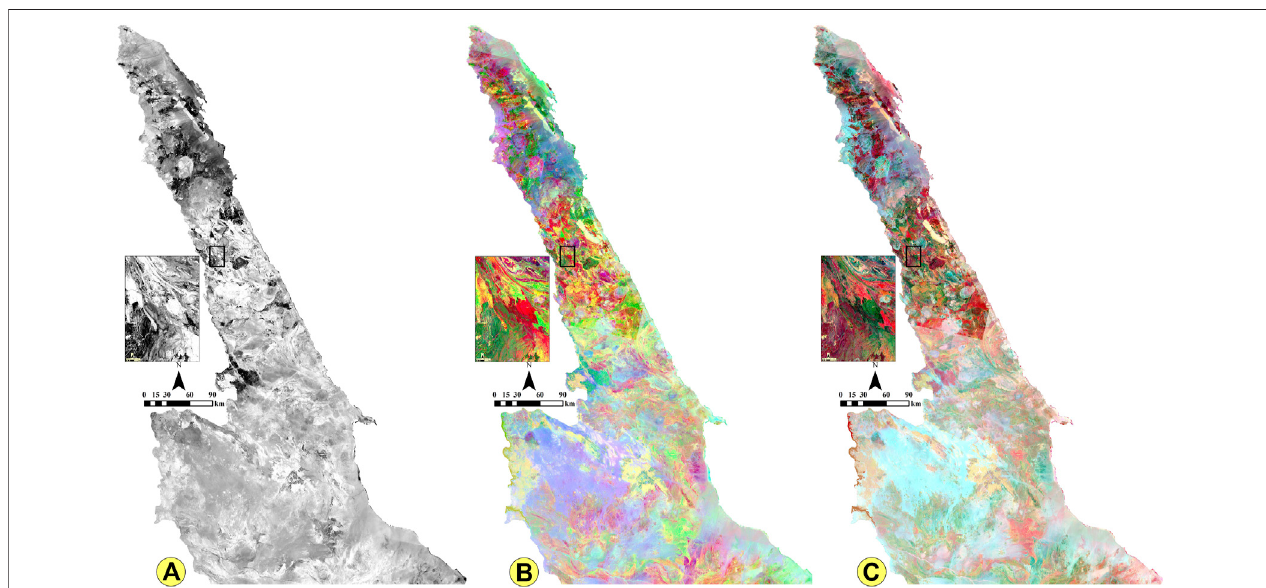
FIGURE 5 | Lithological discrimination using band ratios of Landsat-8 OLI data. (A) Gray-scale band ratio BR (6/5) used for mineralogical identi fi cation. Ultrama fi c andma fi crocksappearaslighttodarkgraypixelswherethefelsicrocksappearaswhitepixels. (B) EffectivebandratioRGB(6/5,6/7,4/2)highlightsophiolitesasbright green, metavolcanics and metasediments as reddish-yellow, Hammamat sediments, and Dokhan Volcanics as dark green and syn to late/post tectonic granitoids as pale blue and violet signatures. (C) Band ratio RGB (6/7, 6/2, 4/2) spectrally discriminates ophiolites as blood red, metavolcanics and metasediments as greenish orange, Hammamat sediments and Dokhan Volcanics as dark brown and syn to late/post tectonic granitoids as light cyan pixels color. The extensional faults, dyke swarms, foliation, thrusts, and strike-slip faults are also enhanced. The inset image is an enlarged area for more details.